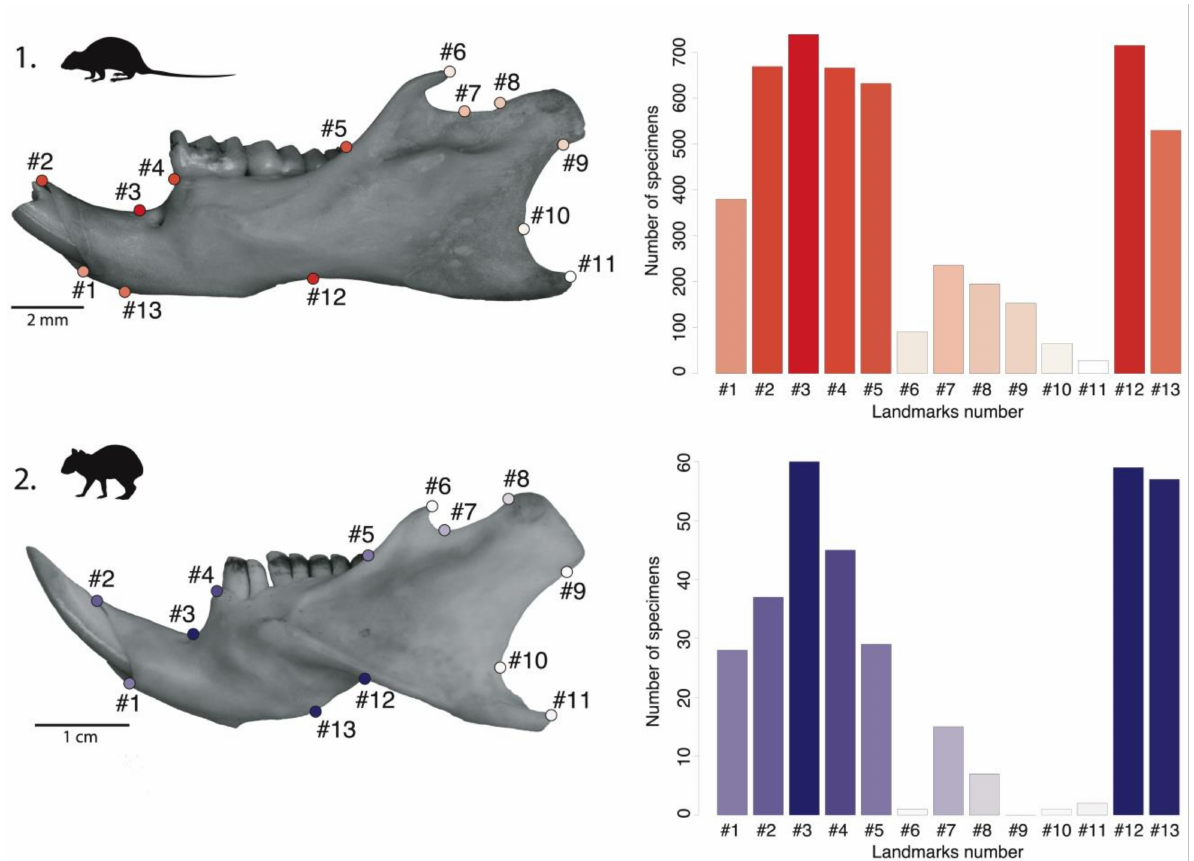
Figure 2. ( Left ) Protocols for positioning the landmarks for the Oryzomyini ( 1 ) and for the Dasyprocta ( 2 ) colored according to the values of the histogram ( Right ) representing the number of mandibles on which each type of landmark was measured (Oryzomyini NISP = 767, Dasyprocta NISP = 66). (See Table S3 for the landmark